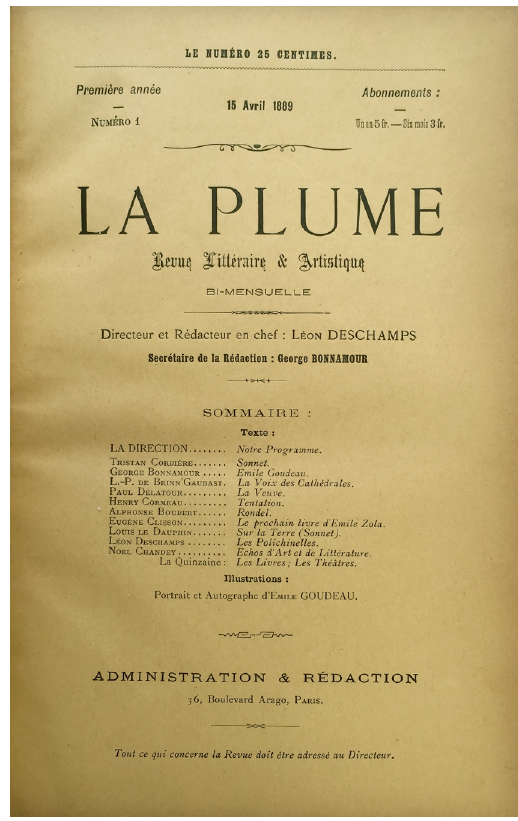
La Plume (15 April 1889), front